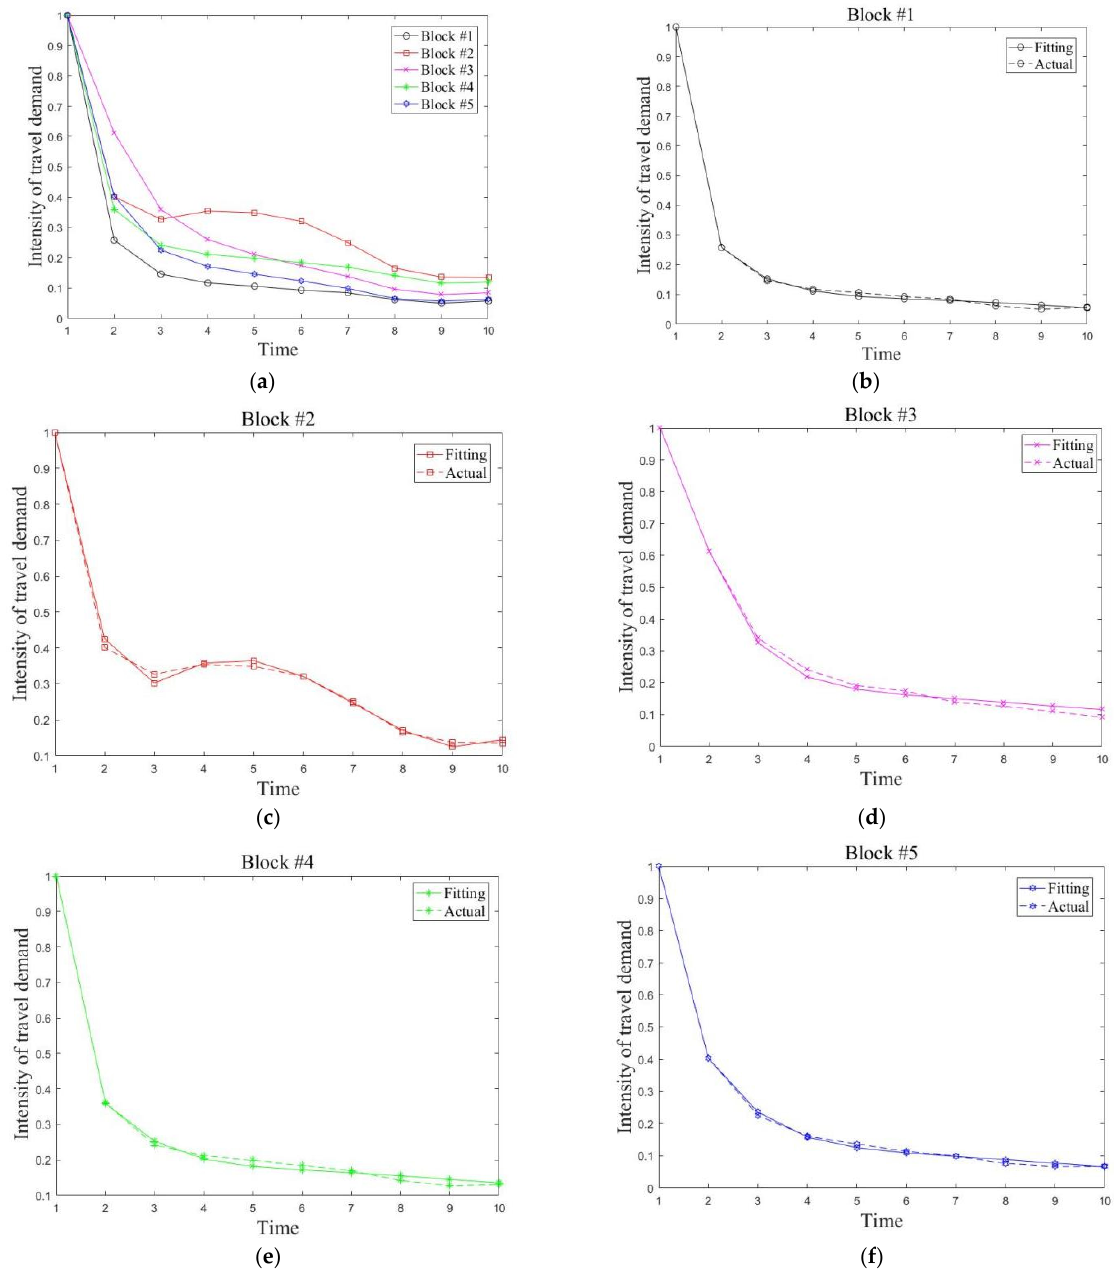
Figure 9. Demand intensity trend acquired by simulation. ( a ) Demand intensity simulation for all blocks. ( b ) Demand intensity simulation for block #1. ( c ) Demand intensity simulation for block #2. ( d ) Demand intensity simulation for block #3. ( e ) Demand intensity simulation for block #4. ( f ) Demand intensity simulation for block #5.